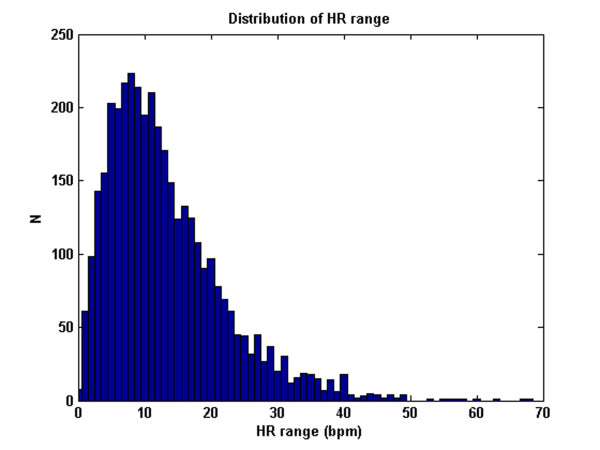
The distribution of true HR range (HRmax-HRmin) of the clean dataset comprising 3762 data segments of 1 hour or longer continuous waveform data (1.62 ± 0.69 h).